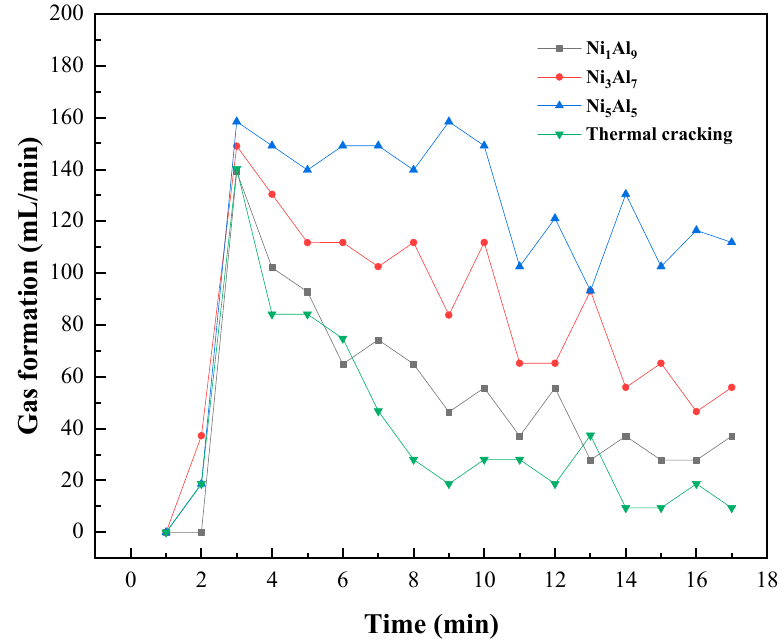
Figure 10. Gas formation profiles at 450 °C and 4 MPa.